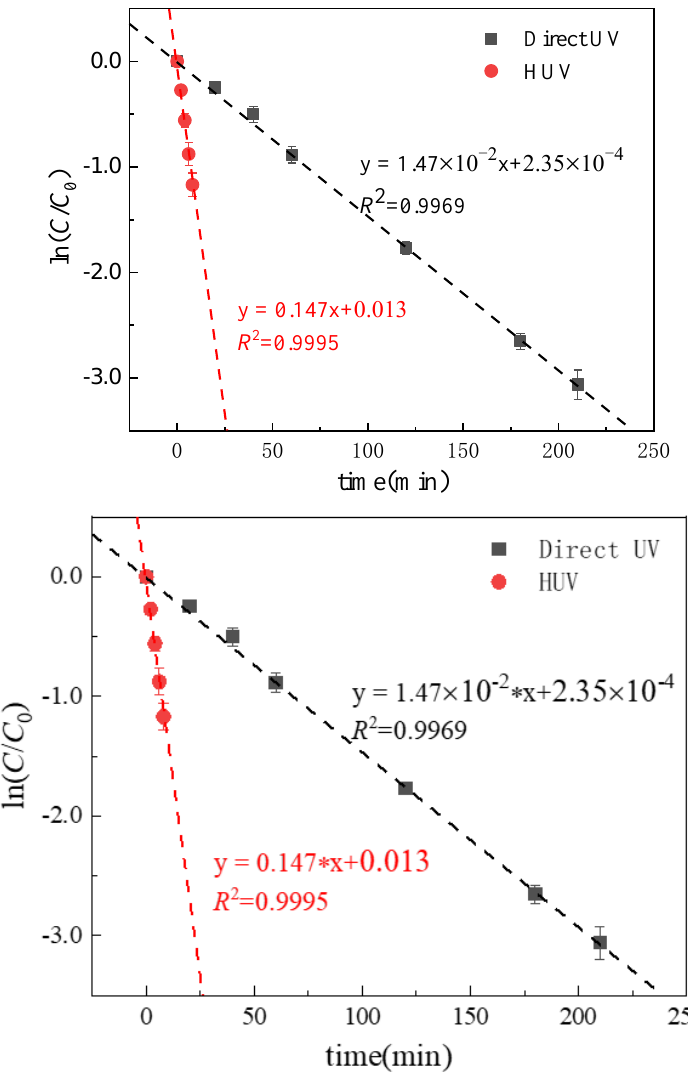
Figure 3. Time-dependent degradation kinetics of MTZ in the UV, UV/H 2 O 2 system. The degradation Figure 3. Time ‒ dependent degradation kinetics of MTZ in the UV, UV/H 2 O 2 system. The degrada- was fitted to a first-order kinetic model (lines). ([MTZ] = 10 µ M, [H 2 O 2 ] = 100 µ M, I 0 = 7.50 × 10 − 6 tion was fitted to a first ‒ order kinetic model (lines). ([MTZ] = 10 μM, [H 2 O 2 ] = 100 μM, I 0 = 7.50 × 10 − 6 Einstein L − 1 · s − 1 , l = 0.935 Einstein L − 1 ·s − 1 , l = 0.935 cm.)